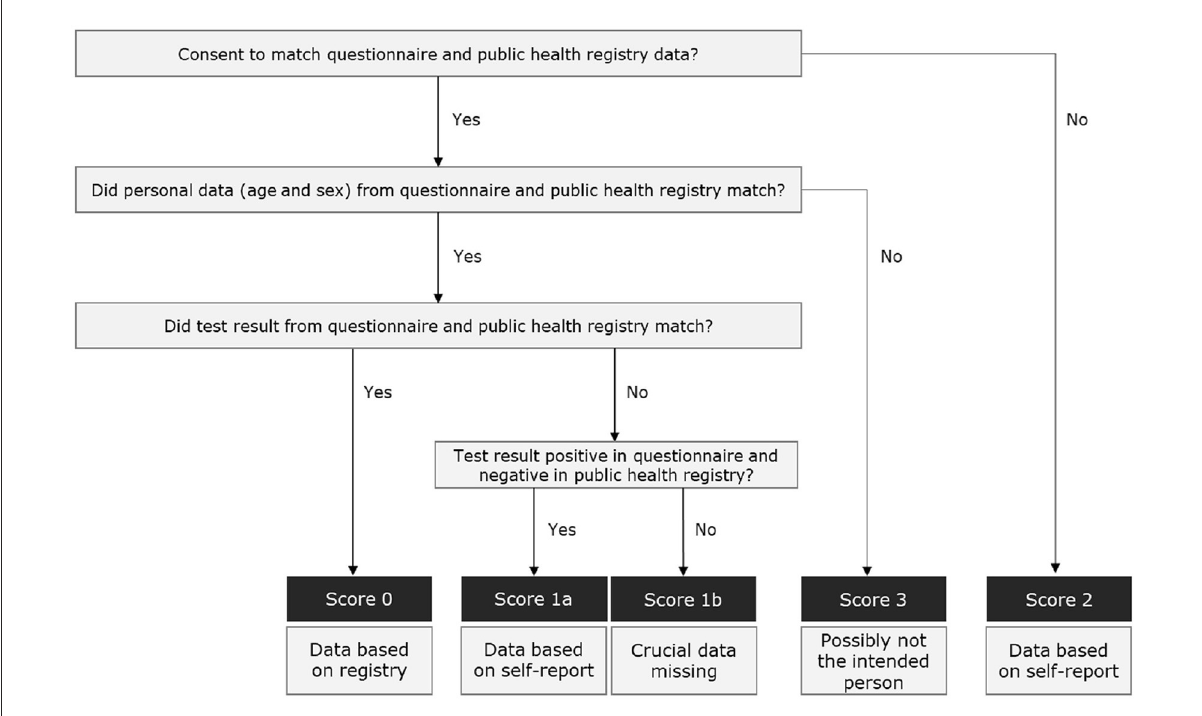
FIGURE2 Decision tree to ascertain certainty assessment scores based on self-reported and public health registry